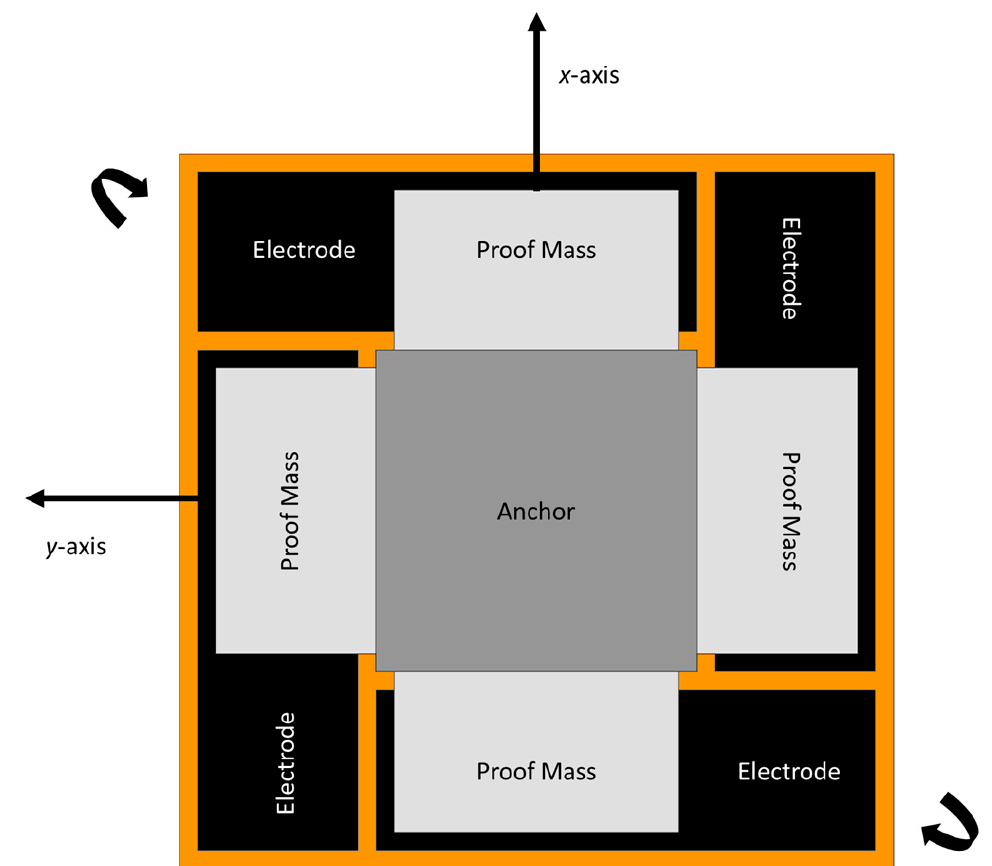
Figure 19. Schematic diagram of novel two-dimensional micromachined gyroscope developed by Fujita et al.